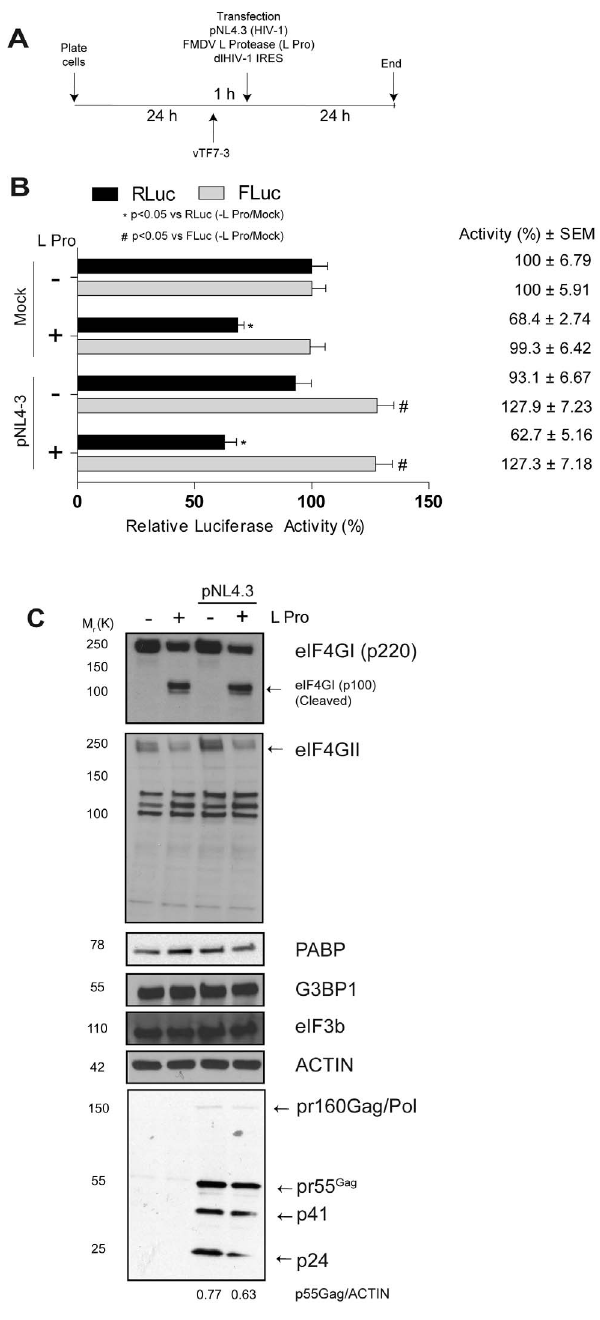
Figure 3. Examination of HIV-1 IRES expression and expression levels of viral proteins during the expression of FMDV L protease in cells. (A) Schematic representation of the experimental protocol. (B). IRES activity levels were determined as described in Materials and Methods. RLuc and FLuc activities of the dl HIV-1 IRES in the uninfected ‘‘mock’’ cells in the absence of FMDV L protease were arbitrarily set to 100%. Statistical analysis was performed by the Student’s t -test (p , 0.05) where (*) represents a significant difference v/ s RLuc activity in uninfected ‘‘mock’’ cells in the absence of L Pro, while ( # ) represents a significant difference v/s FLuc activity in uninfected ‘‘mock’’ cells in the absence of L Pro (C). Whole cell lysates were analyzed for host eIF4GI, eIF4GII, PABP, G3BP1, eIF3b, Actin and pr55 Gag by western blotting analyses.